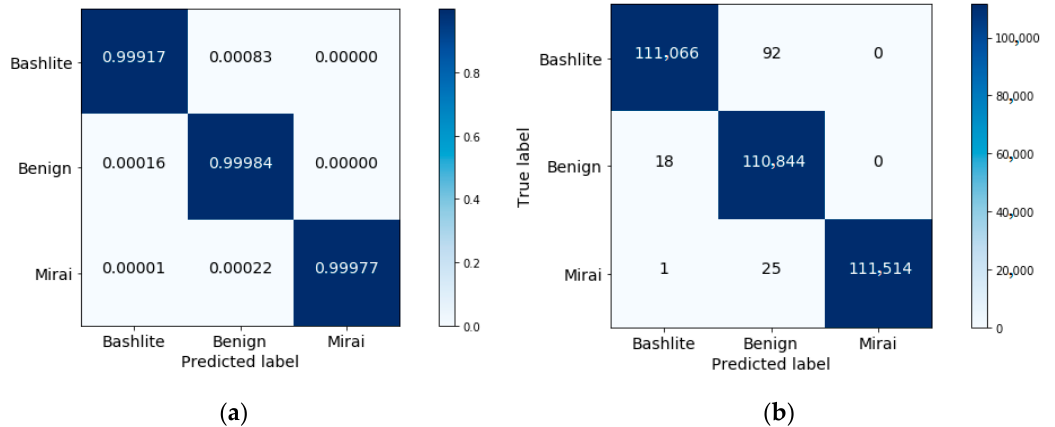
Figure 10. A confusion matrix for Mirai, Bashlite, and benign classification: ( a ) with normalization;